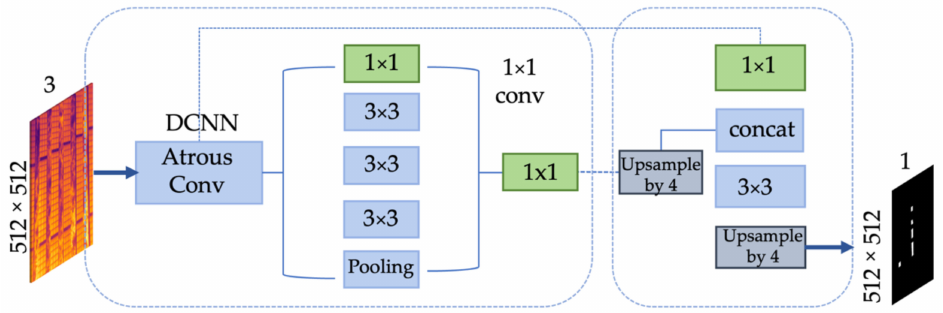
Figure 5. Framework of DeepLabV3+ architecture.